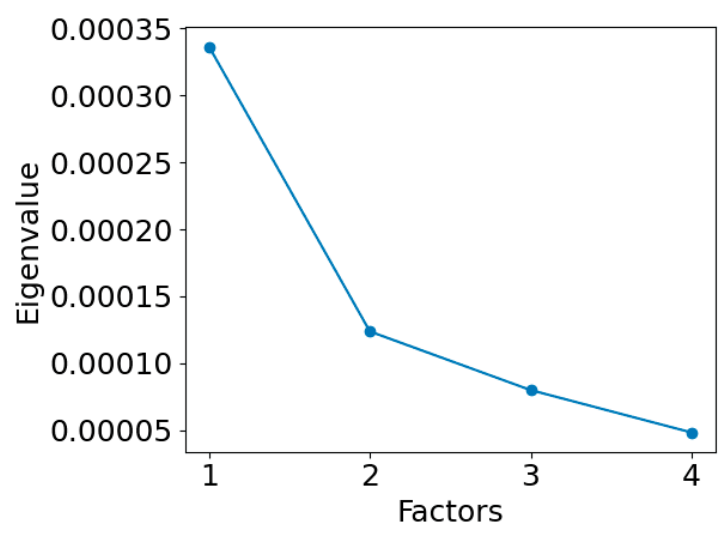
Figure 10. Sorted eigenvalues with descending order.